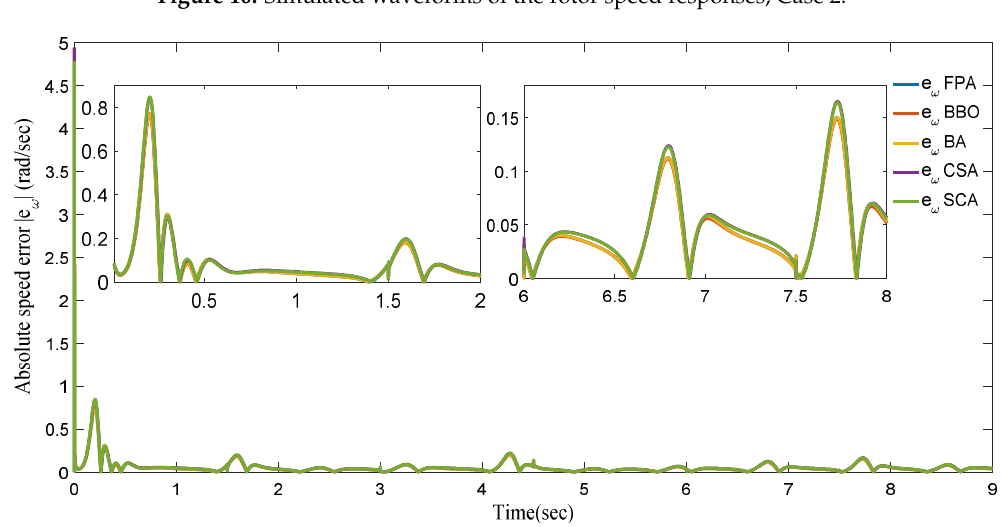
Figure 10. Simulated waveforms of the rotor speed responses, Case 2.